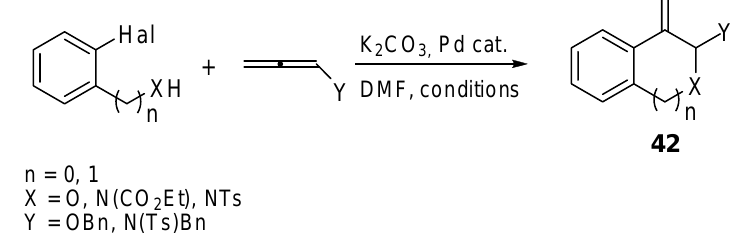
Scheme 20. Annulation reaction of heteroatom-substituted